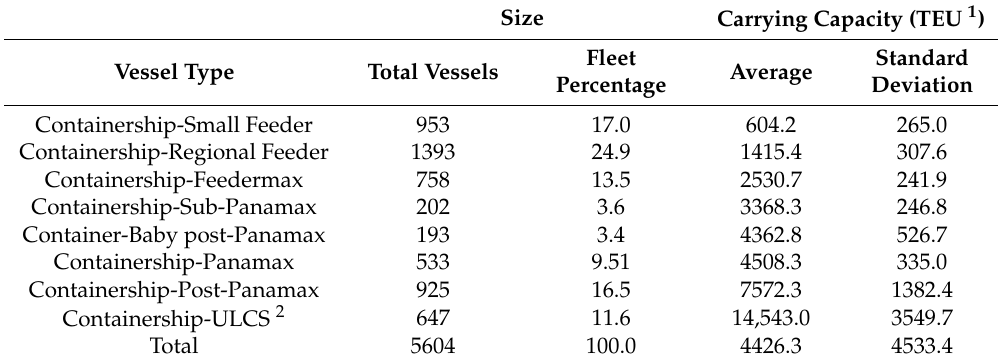
Table 1. Size and carrying capacity of the container shipping fleet by vessel type,